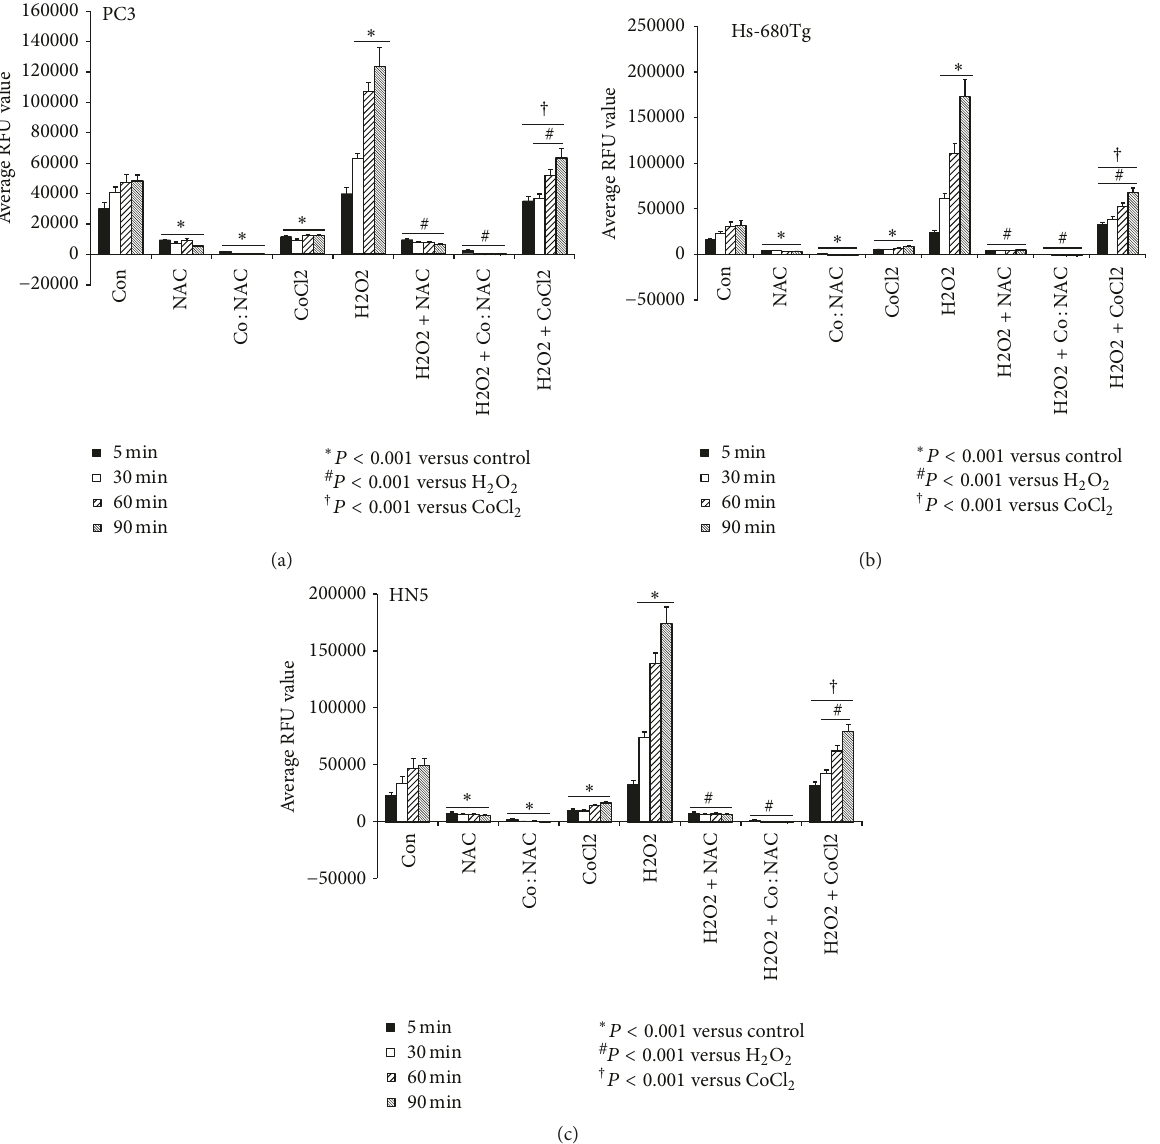
Figure 1: Changes in intracellular reactive oxygen species (ROS)levels over timein responseto various treatment conditions. Human prostate cancer cells (PC3, (a)), human normal tongue cells (Hs-680Tg, (b)), and human head and neck cancer cells (HN5, (c)) were treated with components of the novel MRI positive-contrast marker C4 as follows: 1% [w/v] CoCl 2 ⋅ 6H2O, 2% [w/v] N-acetylcysteine (NAC), or the combined Co:NAC solutions (1%: 2% [w/v]), in the presence or absence of 1000 𝜇 M H 2 O 2 . At 5, 30, 60, or 90 minutes after treatment, intracellular ROS levels were evaluated. Controls (Con) are cells not treated and not exposed to H 2 O 2 . The ROS levels were measured in terms of relative fluorescence units (RFUs) at excitation and emission wavelengths of 485 nm and 535 nm. Values shown are means ± SEM from at least 3 independent experiments. Student’s 𝑡 -tests (unpaired, unequal variance) were used for